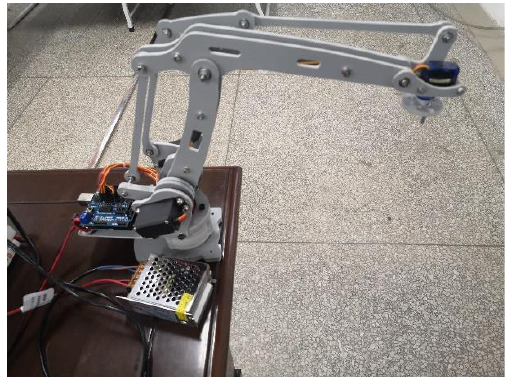
Figure 8. Motion-planning experiment of pollen-picking manipulator.